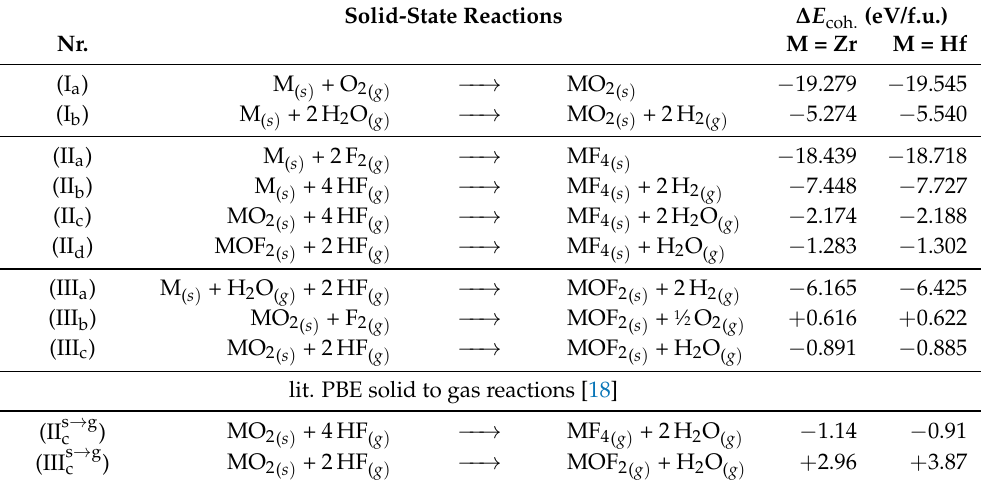
Table 2. Calculated PBE bulk solid-state cohesive energies ( ∆ E coh. ) per formula unit (f.u.) for formations of different Zr/Hf-species of oxides (I), fluorides (II), and oxofluorides (III). Below, the literature values [18] for the respective bulk solid-state to gas-phase reactions (s → g) are given. Solid-State Reactions ∆ E coh. (eV/f.u.)